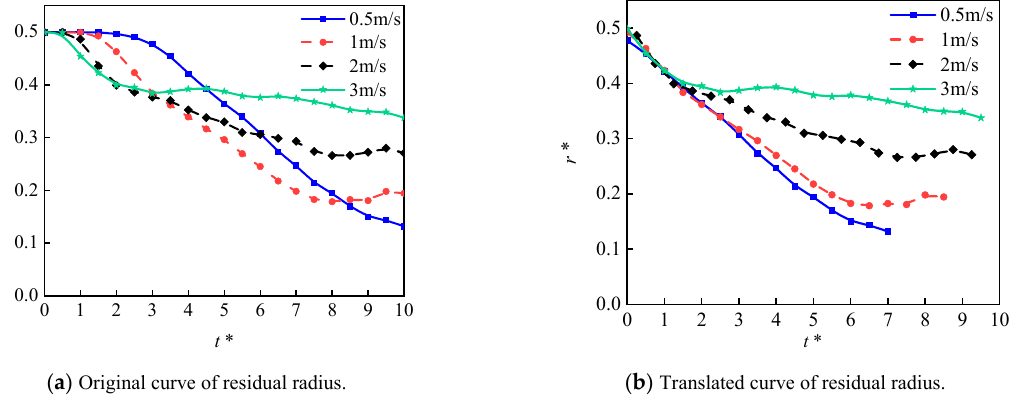
Figure 23. Droplet vaporization on the smooth surface with the various impinging velocities. Figure 24. Droplet vaporization on the micro-structured surface with various impinging velocities.